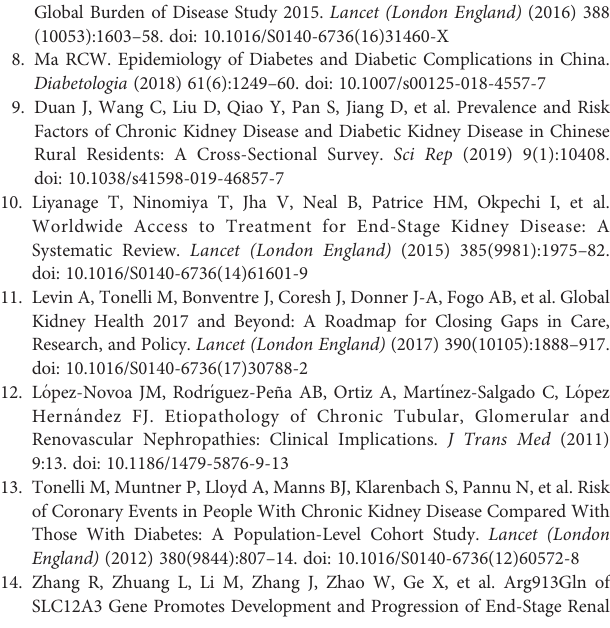
Supplementary Figure 1 | Gene Ontology (GO) term enrichment analysis of upregulated genes in the three datasets (EDN: GSE111154, GDKD: GSE30528 and TDKD: GSE30529). GO analysis of the upregulated genes were examined for three sub-ontologies (biological process, molecular function, and cellular component). Supplementary Figure 2 | Gene Ontology (GO) term enrichment analysis of downregulated genes in the three datasets (EDN: GSE111154, GDKD: GSE30528 and TDKD: GSE30529). GO analysis of the downregulated genes were examined for three sub-ontologies (biological process, molecular function, and cellular